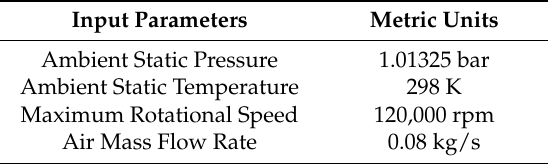
Table 1. Operating conditions for the centrifugal compressor.